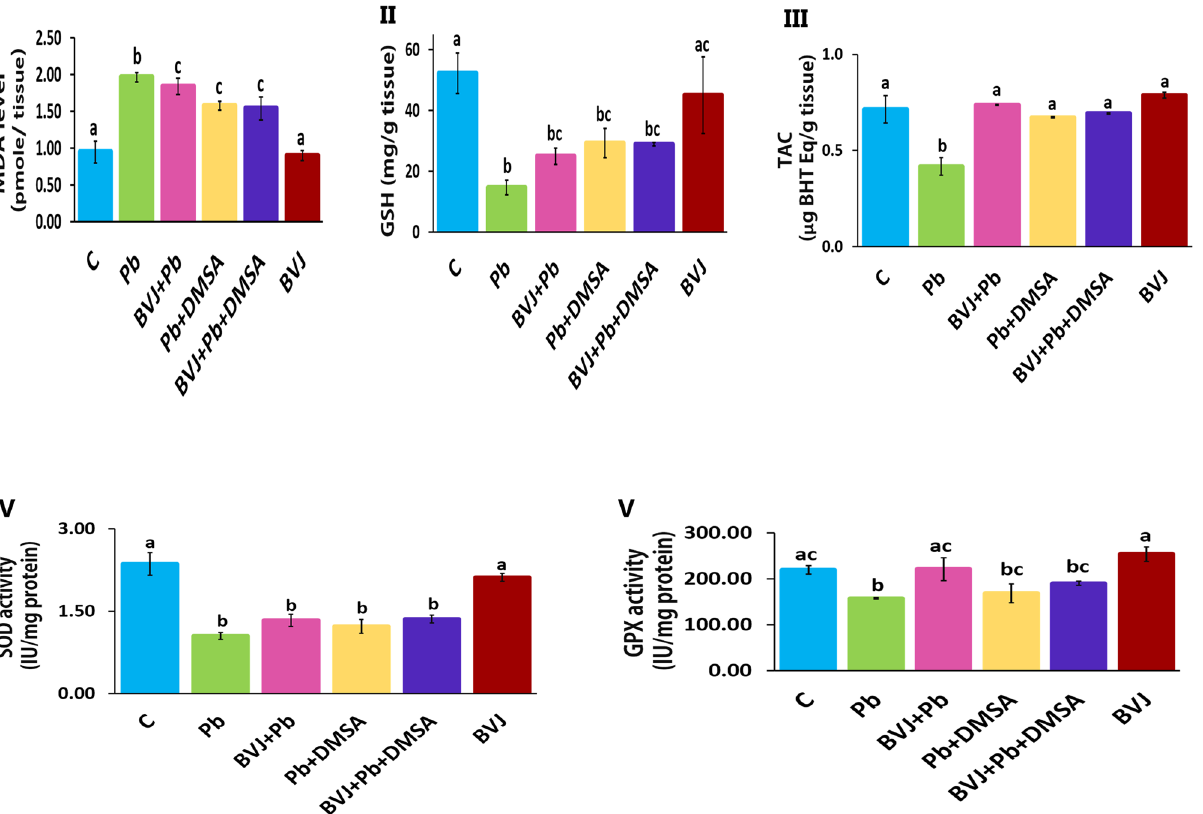
Figure 3. The alleviating influences of Beta vulgaris juice (BVJ), dimercaptosuccinic acid (DMSA), and their combination (BVJ + DMSA) on Pb-induced oxidative stress in the brain tissue of Pb-intoxicated rats. Where ( I ): lipid peroxidation level in the brain tissue of all the studied groups, ( II ): reduced glutathione (GSH) level in the brain tissue of all the studied groups, ( III ): total antioxidant capacity (TAC) in the brain tissue of all the studied groups, ( IV ): the activity of superoxide dismutase (SOD) in the brain tissue of all the studied groups, and ( V ) glutathione peroxidase (GPX) in the brain tissue of all the studied groups. The results are shown as mean ± SE (n = 8). Different letters for the same parameter are significantly different at p < 0.05. C